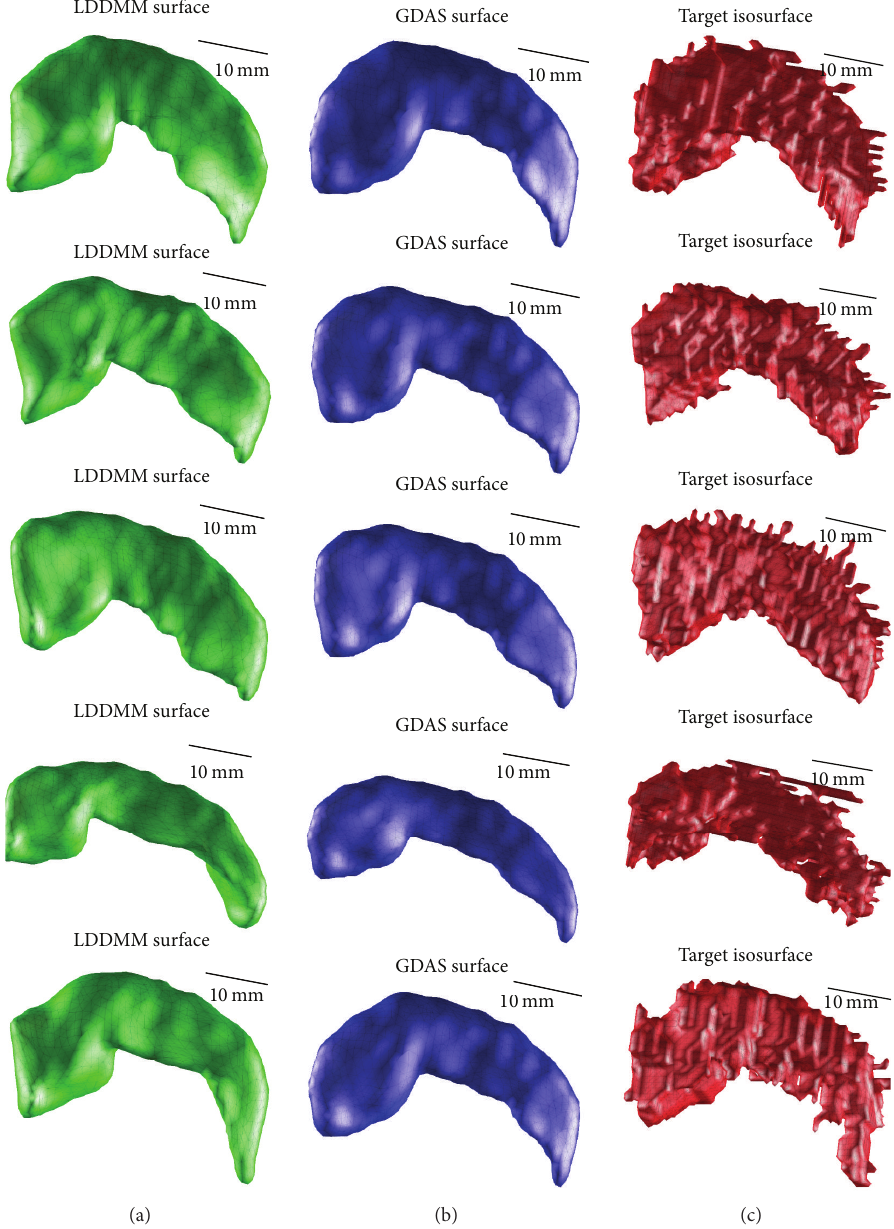
Figure 3: Examples of hippocampus surfaces resulting from using (left/green) surface LDDMM and (center/blue) GDAS surface matching. The target isosurface is shown at the right